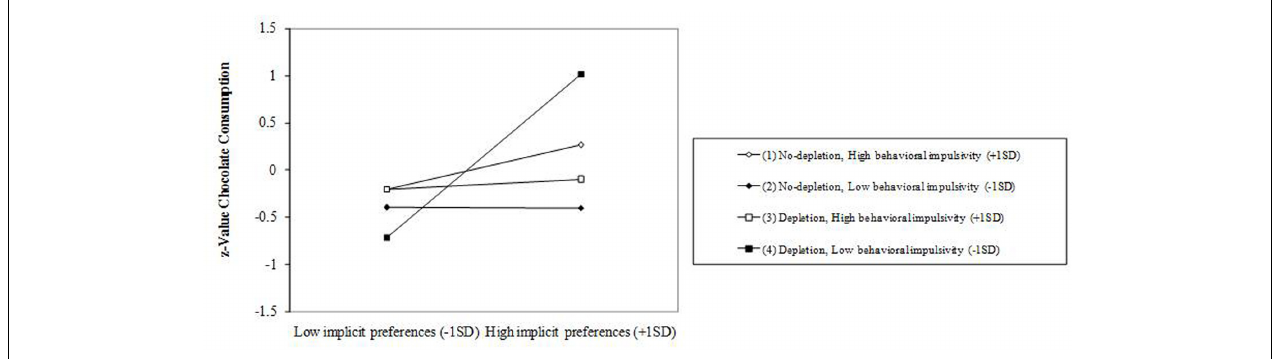
FIGURE 3 | Slopes for implicit preferences-chocolate consumption relationship across levels of ego depletion and behavioral impulsivity.